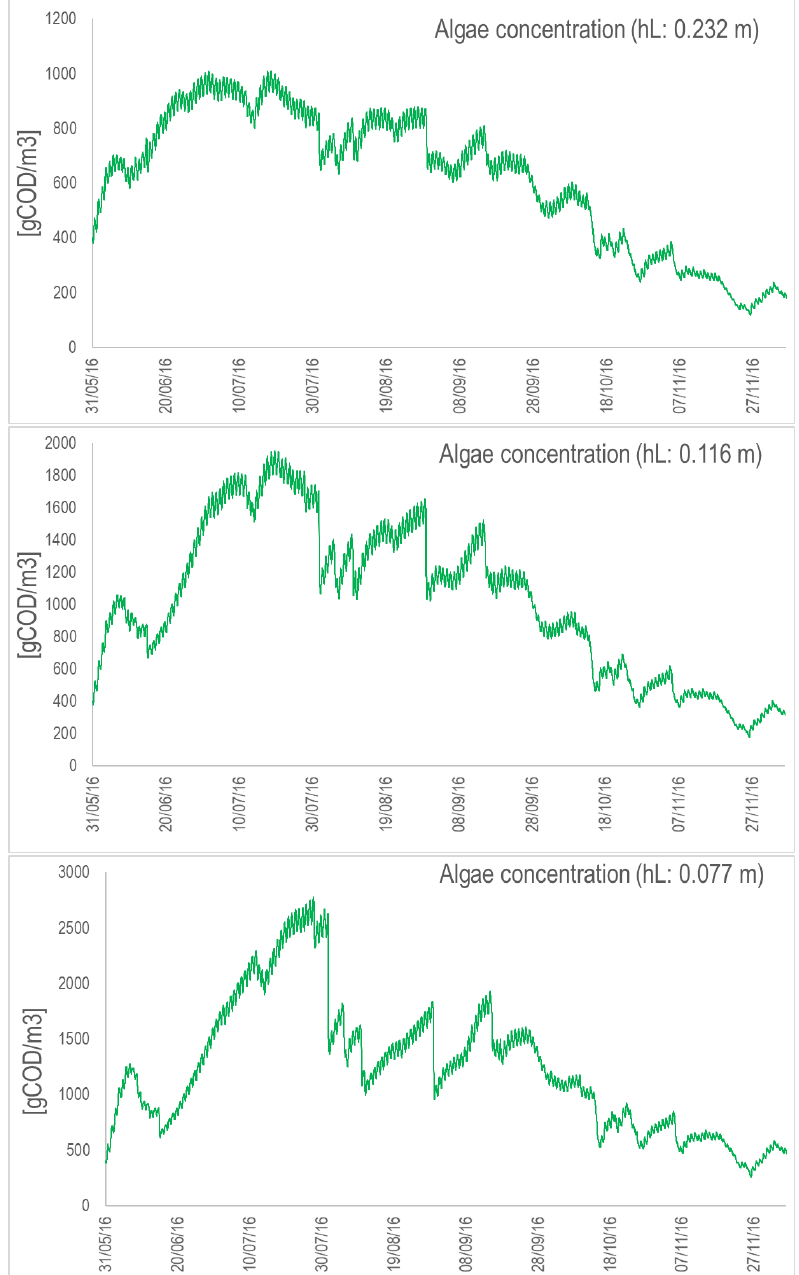
Figure A8. Algal concentration (in COD/m 3 ) for the suspended raceway with the nominal depth ( top ), depth divided by 2 ( middle ), and depth divided by 3 ( bottom ). Simulations are from May to November